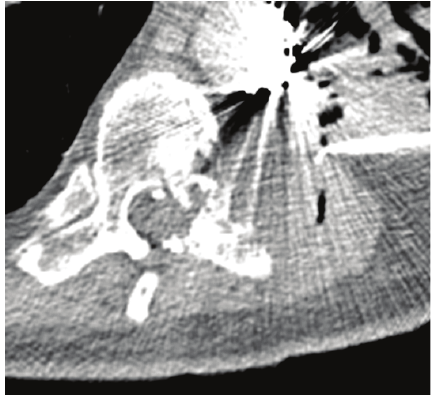
Figure 6: CT T-spine without contrast five months after irinotecan TACE and after pseudoaneurysm coil embolization. Note the metastatic lesion in the left paravertebral/chest wall area which has decreased in size, now measuring 5 . 5cm × 5 .